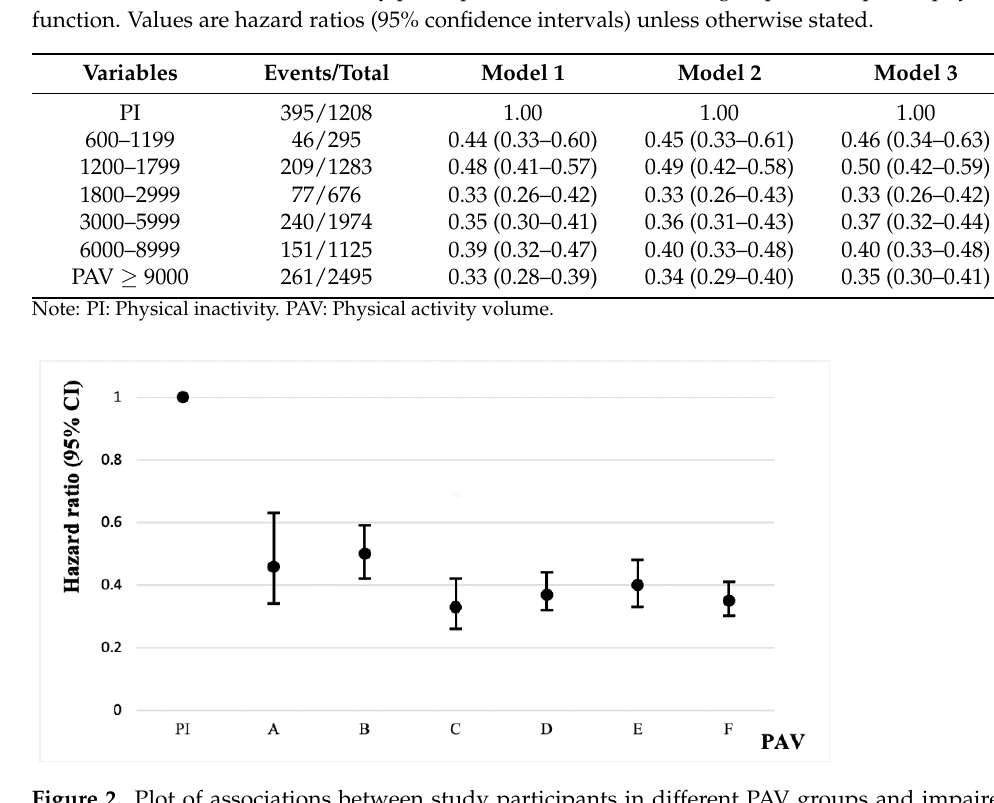
Figure 2. Plot of associations between study participants in different PAV groups and impaired physical function. Whiskers represent 95% confidence intervals. A: 600 ≤ PAV ≤ 1199. B: 1200 ≤ PAV ≤ 1799. C: 1800 ≤ PAV ≤ 2999. D: 3000 ≤ PAV ≤ 5999. E: 6000 ≤ PAV ≤ 8999. F: PAV ≥ 9000. Unit: MET-minutes/week.